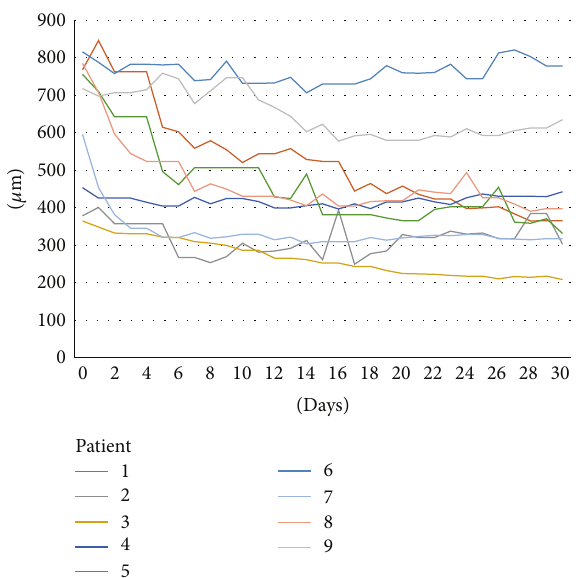
Figure 2: Daily central macular thickness measurements. The different colors represent each